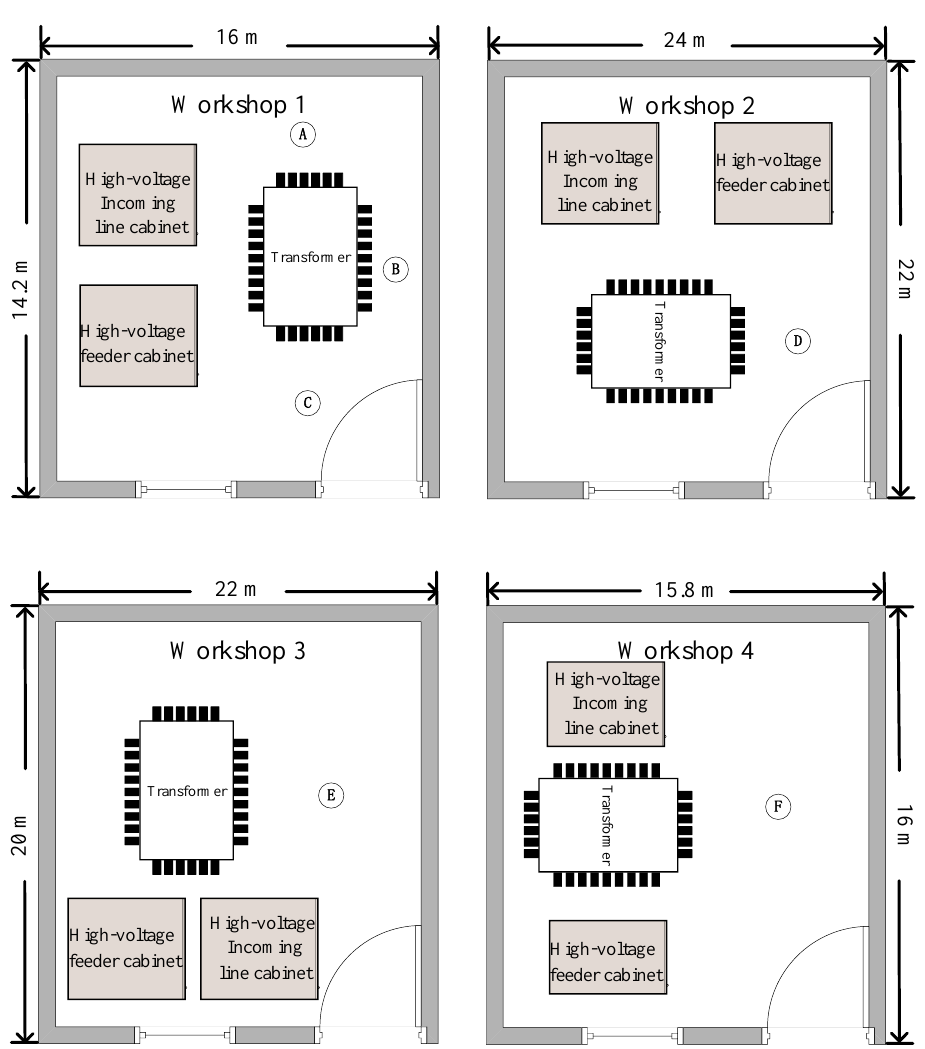
Figure 7. The schematic diagram of the transformer workshops. (A–F is the position of the